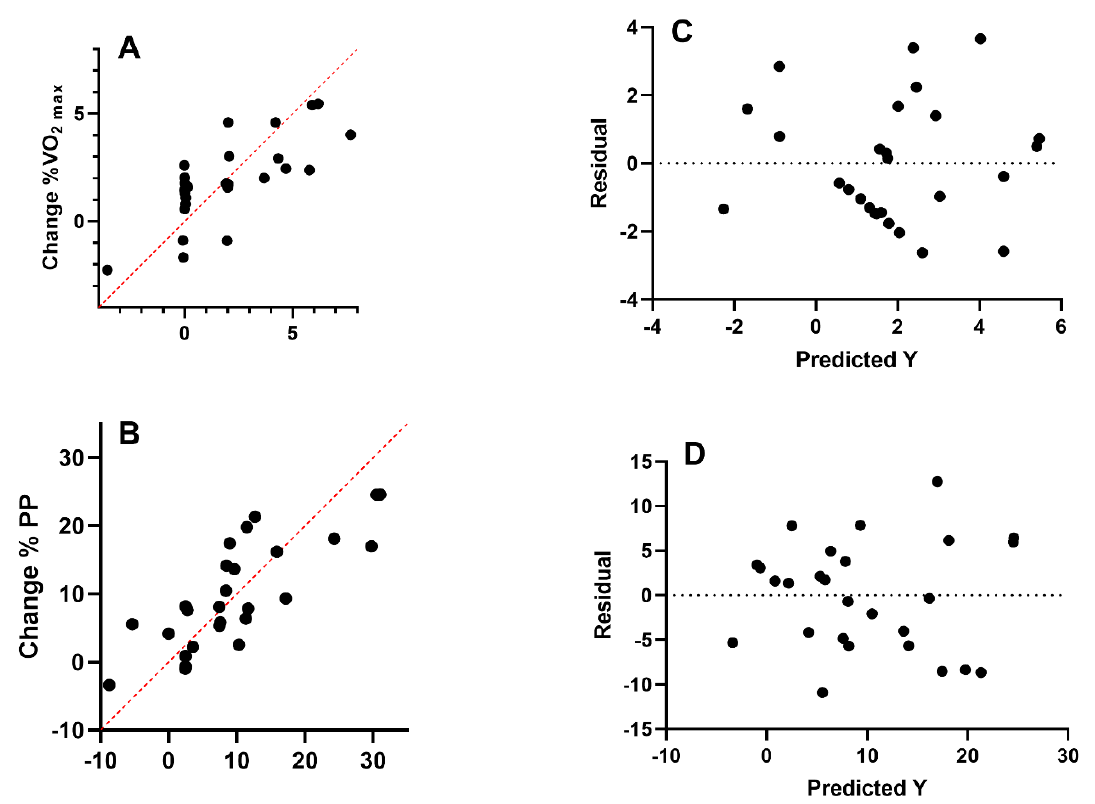
Figure 2. Multiple linear regression analysis was calculated to predict the percentage of change in fitness levels ( A ) VO 2max and ( B ) PP based on accumulated training load, body fat %, maturity, somatotype, and baseline fitness levels in the soccer players. Also, residual plot was calculated to predict the percentage of change in fitness levels ( C ) VO 2max and ( D ) PP; the difference between the actual value of the dependent variable and the value predicted by the residual provided. Note: VO 2max = maximal oxygen consumption (mL.kg −1 .min −1 ); PP = Peak power (watts).